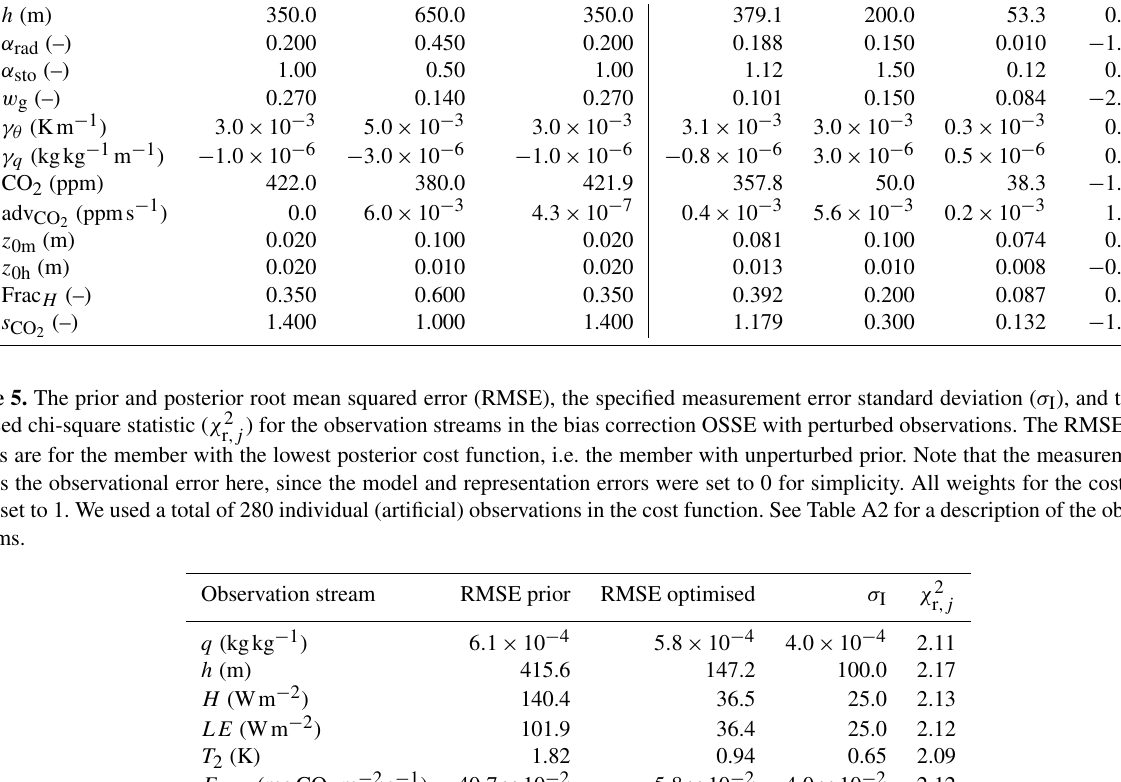
. σ A and , and CO 2 20 2